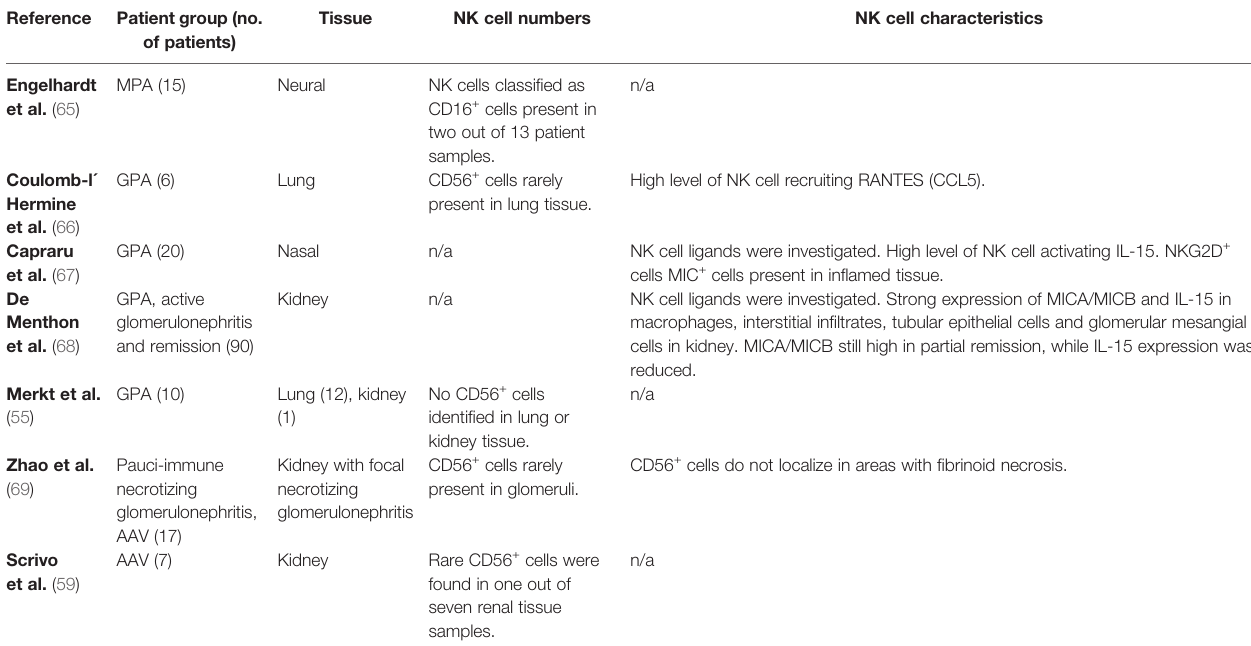
TABLE 2 | NK cells in tissue from AAV